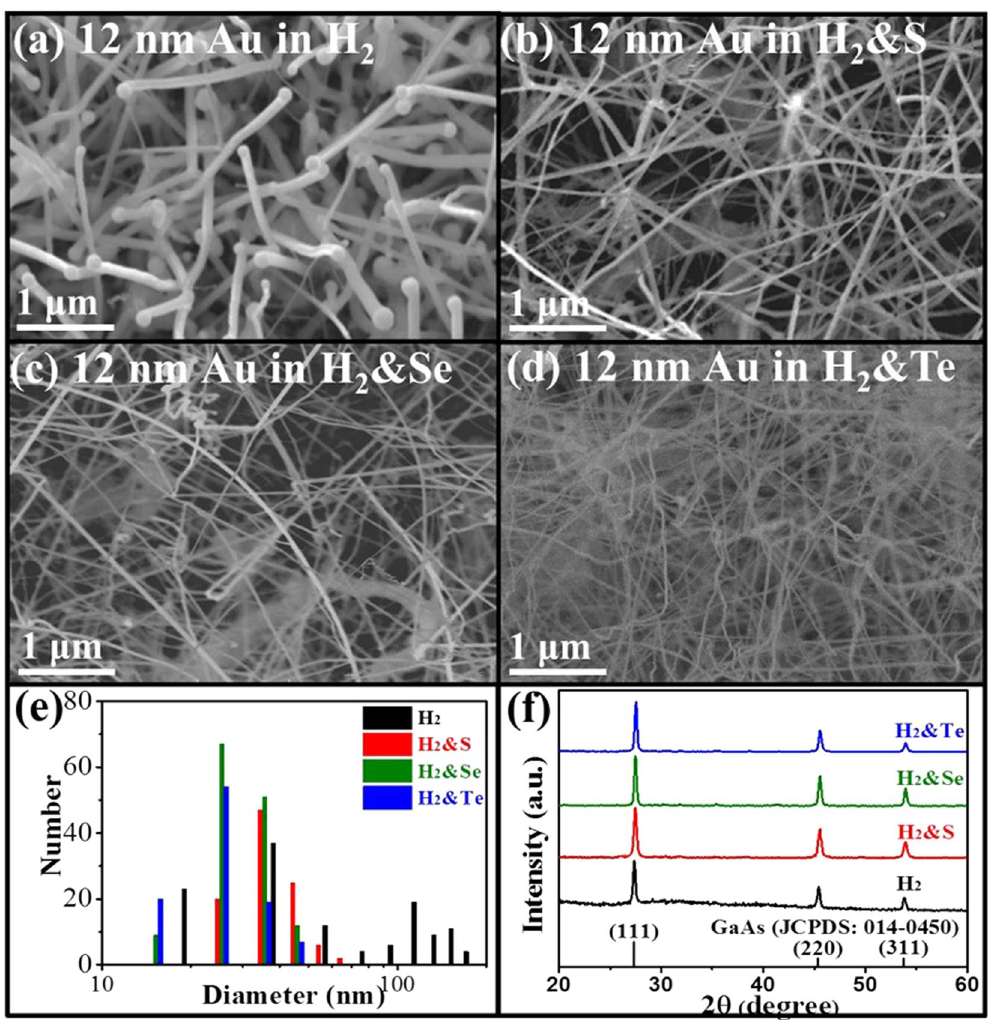
Figure 1. Morphology, diameter comparison and structural characterization of all GaAs NWs prepared by 12 nm thick Au catalyst films in H 2 atmosphere. SEM images of GaAs NWs prepared ( a ) without any chalcogen passivation, ( b ) with S passivation, ( c ) with Se passivation and ( d ) with Te passivation during the NW growth; ( e ) diameter distribution of NWs grown without and with the chalcogen passivator; ( f ) XRD patterns of the as- prepared GaAs NWs.